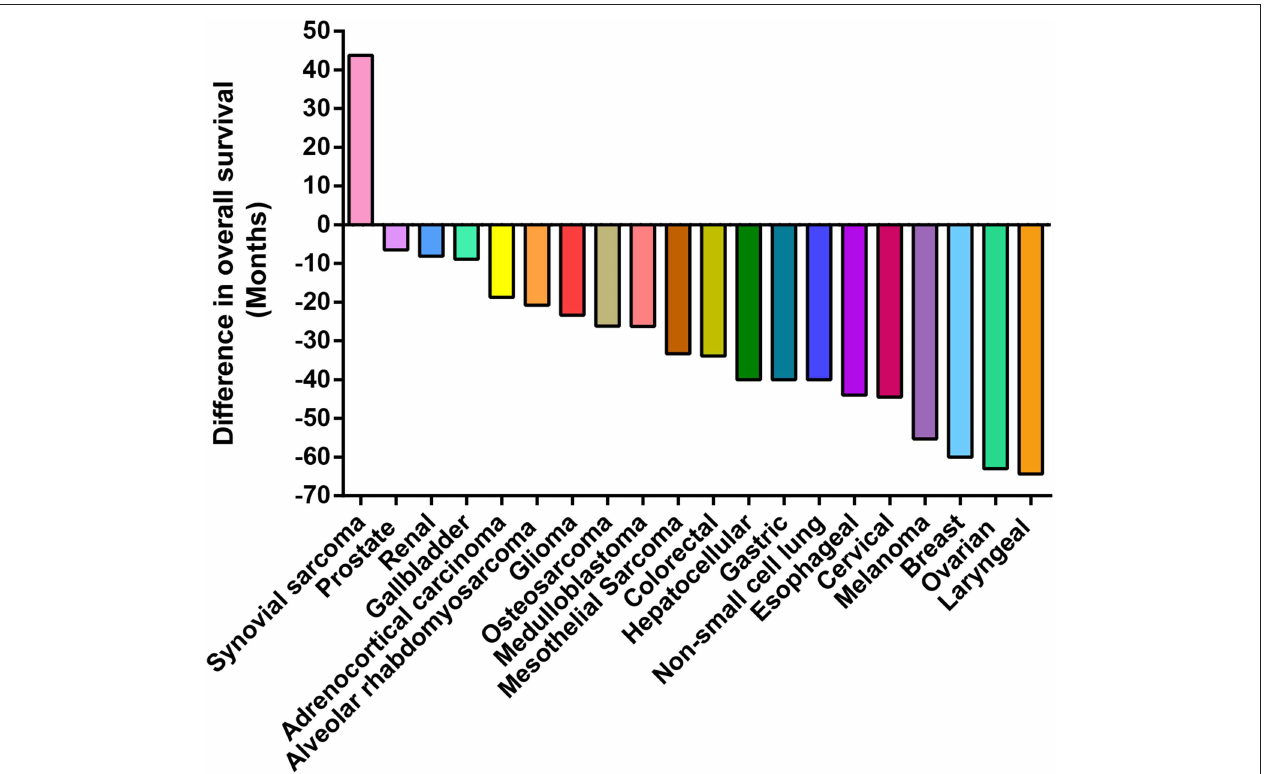
FIGURE 3 | Presence of VM is associated with poor patient prognosis. Waterfall plot presenting the difference in survival time (years) of patients presenting structures claimed to represent VM in their tumors. The zero value represents patient survival in the absence of VM. In reports to date VM has a negative impact on the overall patient survival in all but one cohort (synovial